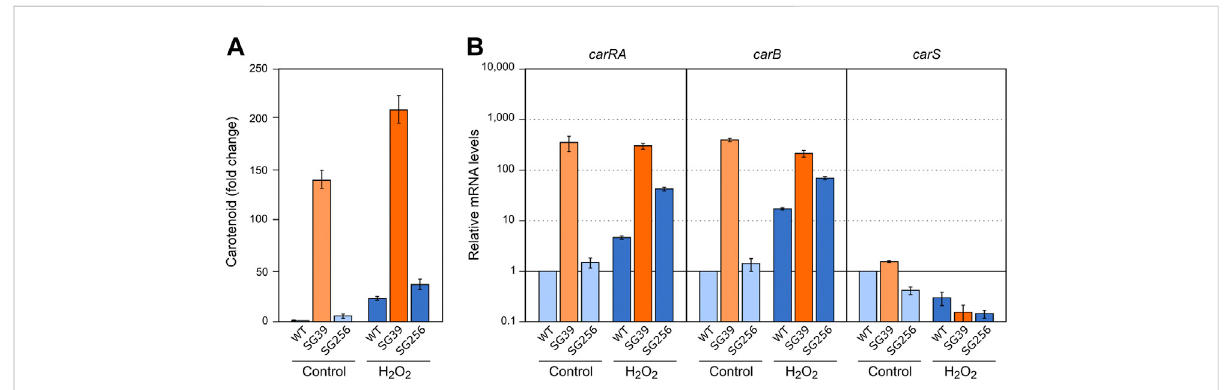
FIGURE 6 Effect of oxidative stress and carS gene mutation on carotenoid production and expression of car genes. (A) Relative carotenoid accumulation after hydrogen peroxide treatment for 24 h in the wild type (WT), carS mutant (SG39), and the complemented mutant (SG256). (B) Expression levels of carRA, carB and carS genes after 1 hour incubation with H 2 O 2 . Control: samples without treatment. Culture conditions are as those for Figure 2. Levels of mRNA were determined by RT-qPCR and referred to the levels in the wild type grown without hydrogen peroxide, taken as